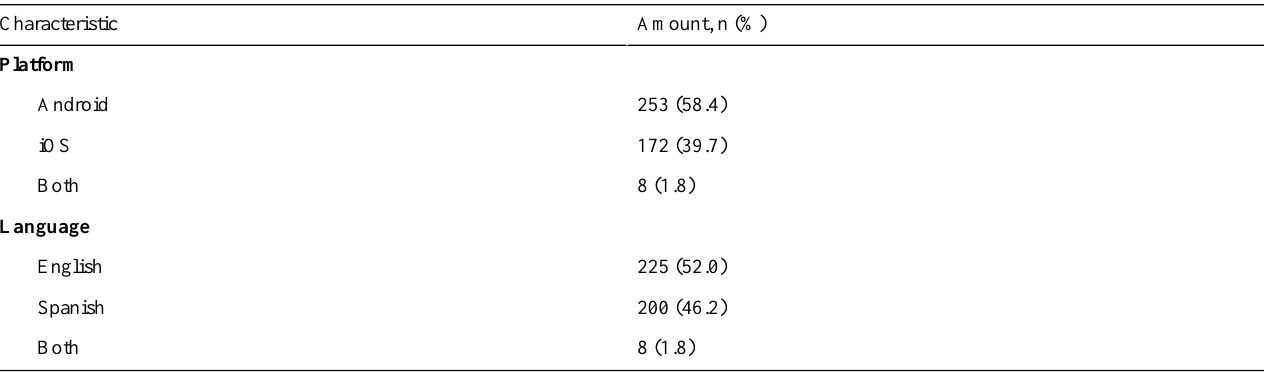
Table 3. App platform and language availability